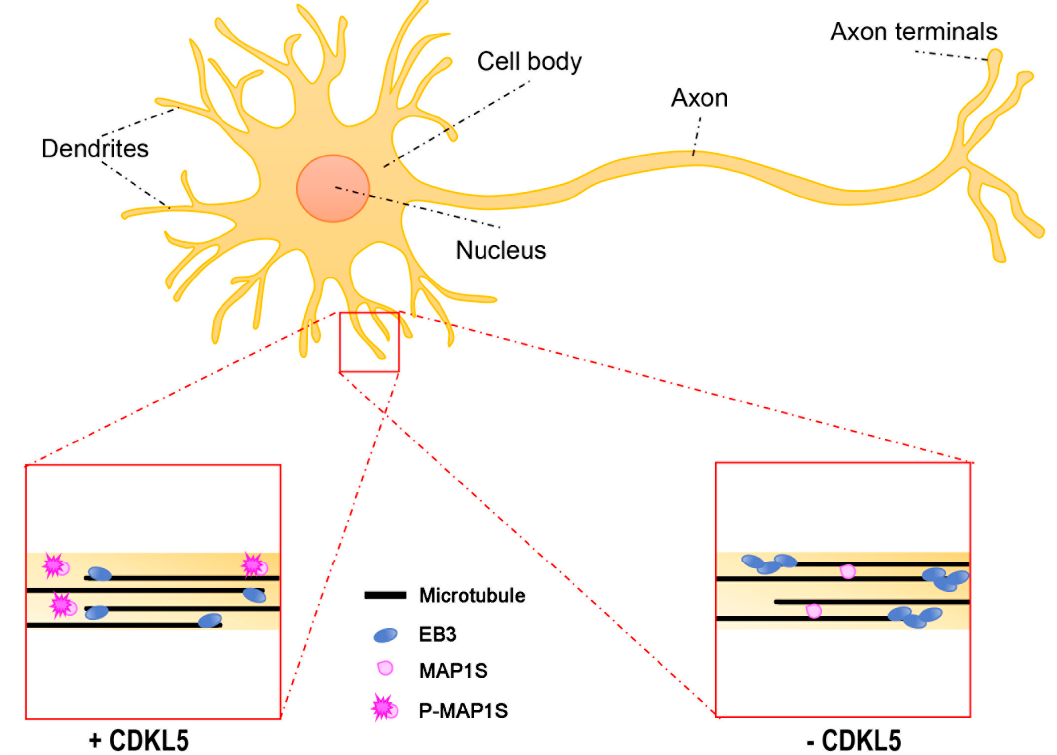
Figure 3. The effect of CDKL5 deficiency on dendritic microtubule dynamics. In dendrites, microtubules (MTs) have mixed orientations with the plus-ends oriented both proximally and distally. CDKL5 phosphorylates MAP1S inhibiting its binding to MTs (lower left). In the absence of CDKL5 (lower right), the binding of MAP1S to MTs is accompanied by increased life-time of EB3 binding to the plus-ends.